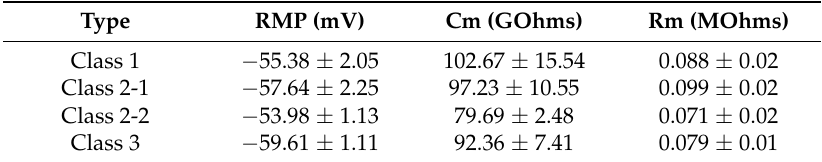
Table 1. Passive membrane properties of different types of large DRG neurons.